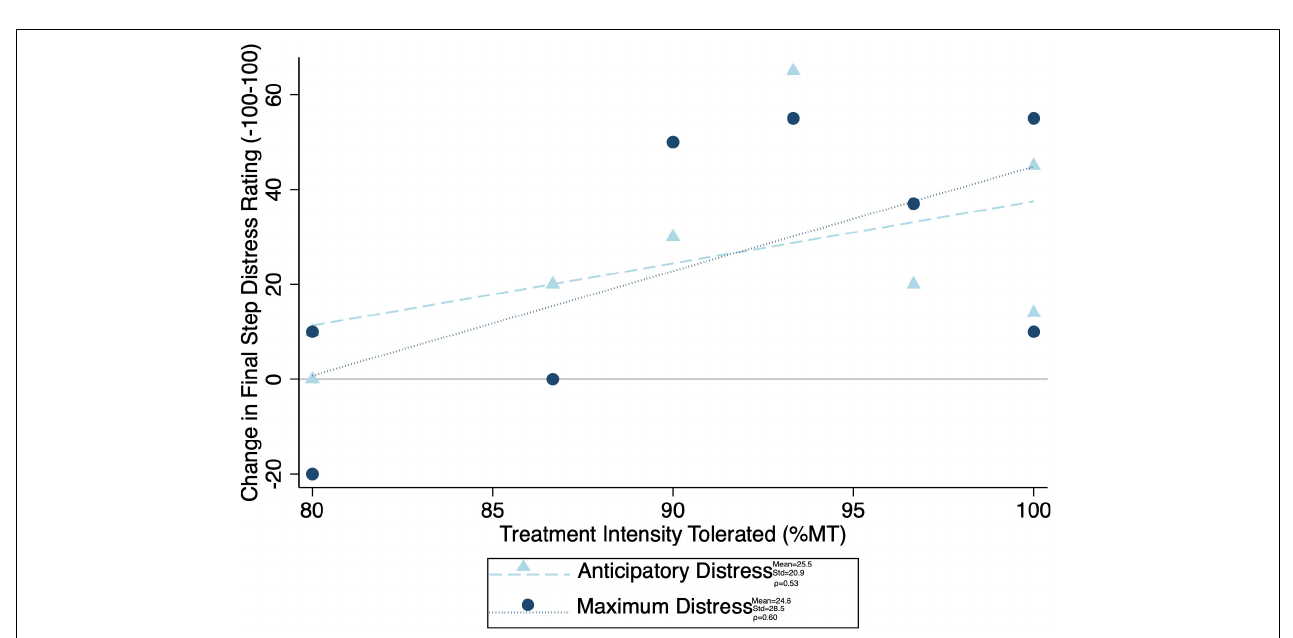
FIGURE 7 | Correlation between average maximum treatment intensity tolerated (noted as a percent of resting motor threshold) and time delay from exposure to TMS. Mean time delay, standard deviation of the delay, and spearman correlation coefficient between treatment intensity and time delay noted for each visit. Pearson correlation was notably lowest at visit 1, and ρ > = 0.7 for all other visits and average delay.